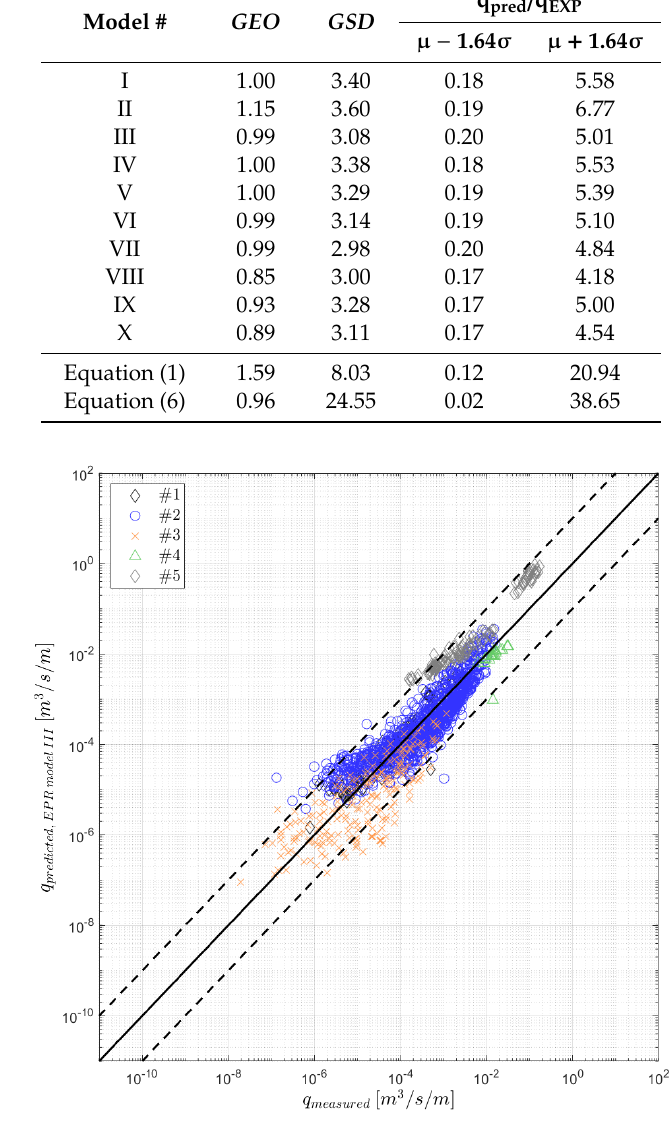
Figure 7. Comparison of overtopping prediction employing EPR model expression III and measured overtopping discharge (solid line: prediction equal to measured rate; dashed lines: prediction equal to 10 times and 0.1 times the measured rate).